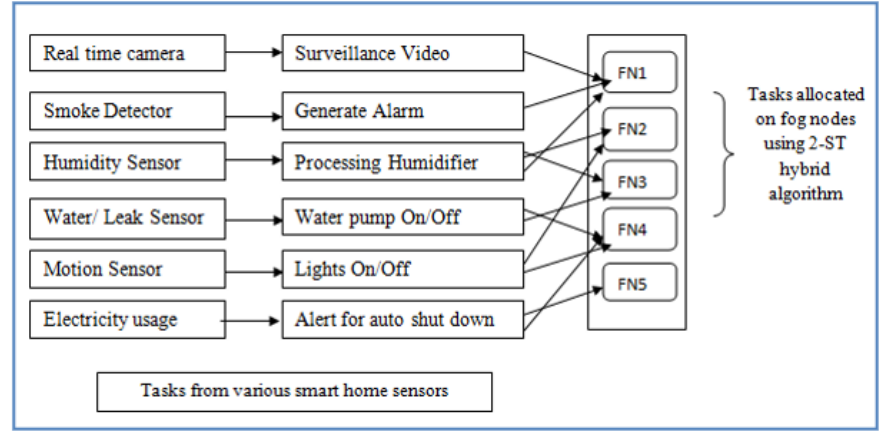
Figure 4. Example of task allocation using the 2-ST hybrid